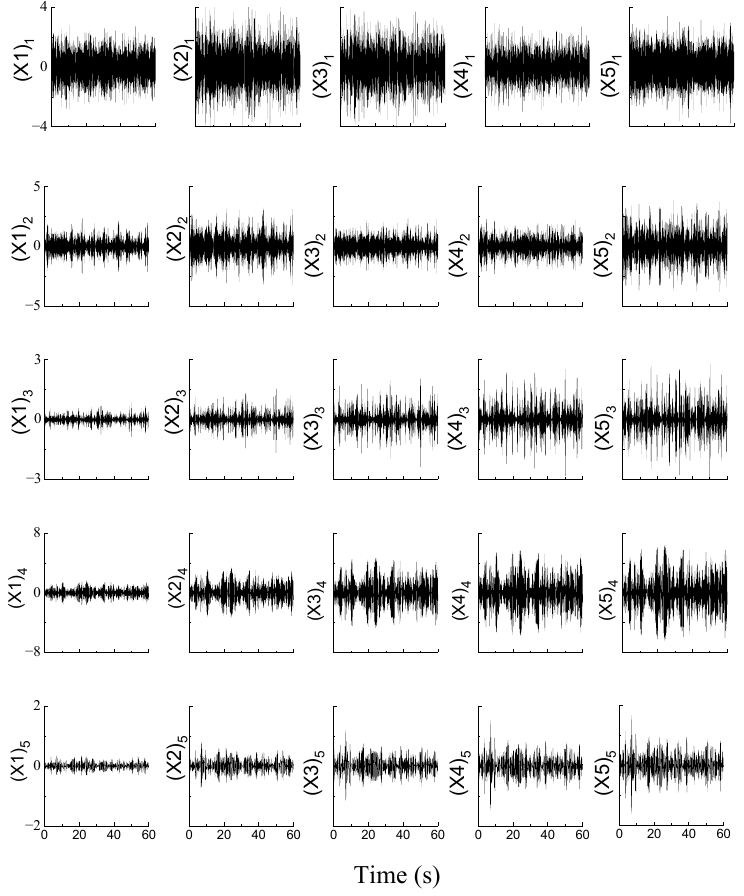
Figure 3. First five IMFs of the 5-storey frame structure by MEMD decomposition.